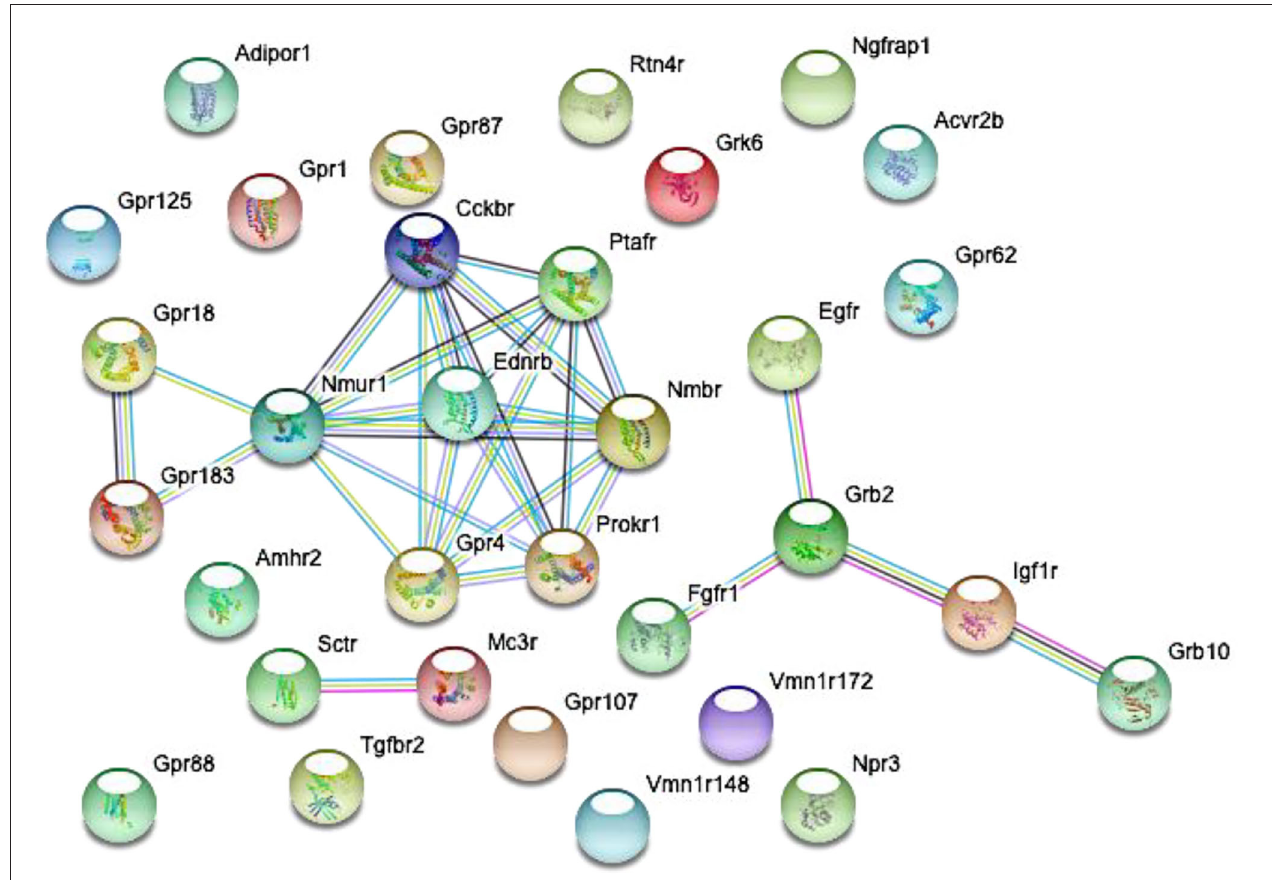
FIGURE 2 | Predicted interactions among proteins encoded by differentially expressed genes in GnRH neurons of intact proestrous mice. The gene network was constructed by using the STRING 10.5 Known and Predicted Protein-Protein Interactions program (http://string-db.org/). Analysis was performed at confidence value of 0.7, and non-interacting elements were also visualized. There are three gene clusters with interacting elements: (1) growth factor receptors : Egfr, Fgfr1, Grb2, Igf1r, and Grb10. (2) Peptide and GPCR receptors: GPR18, Nmur1, Ptafr, Ednrb, Prokr1, Nmbr, Gpr4, and Cckbr. (3) Peptide receptors: Sctr and